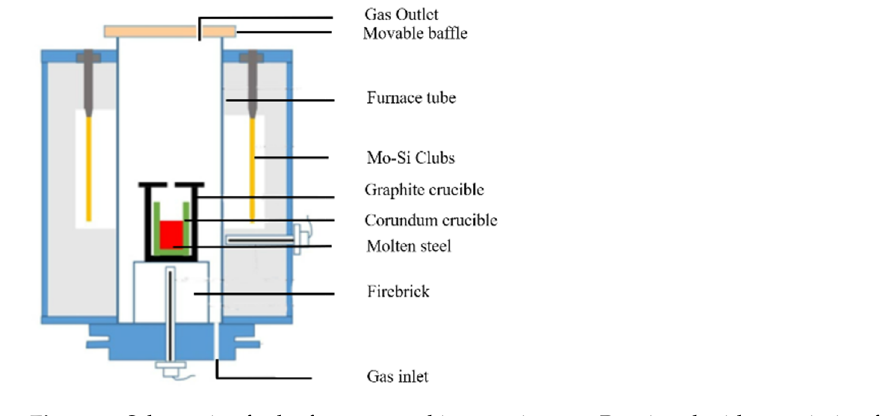
Figure 1. Schematic of tube furnace used in experiments. Reprinted with permission from [28] Table 1. Compositions of raw materials (mass%).